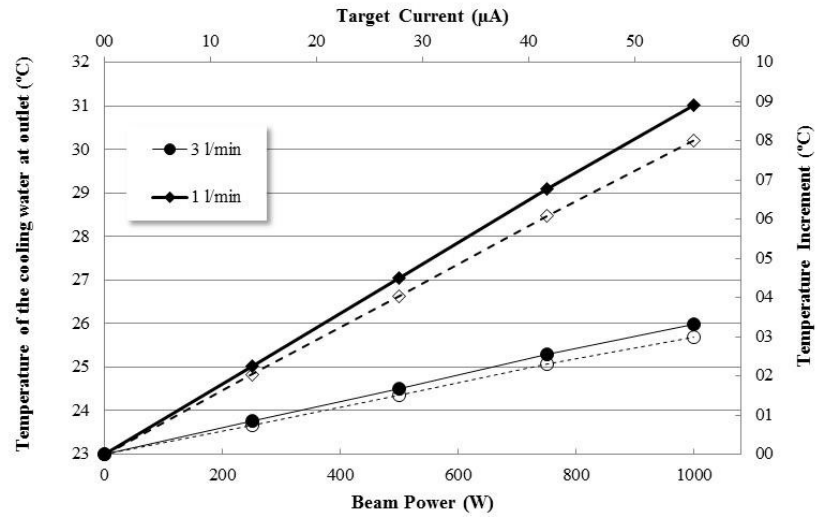
Figure 13. Absolute temperature at outlet (full symbols) and temperature increment (open symbols) for the cooling water as a function of the beam power (and corresponding target current), for two flow rates of the cooling water.